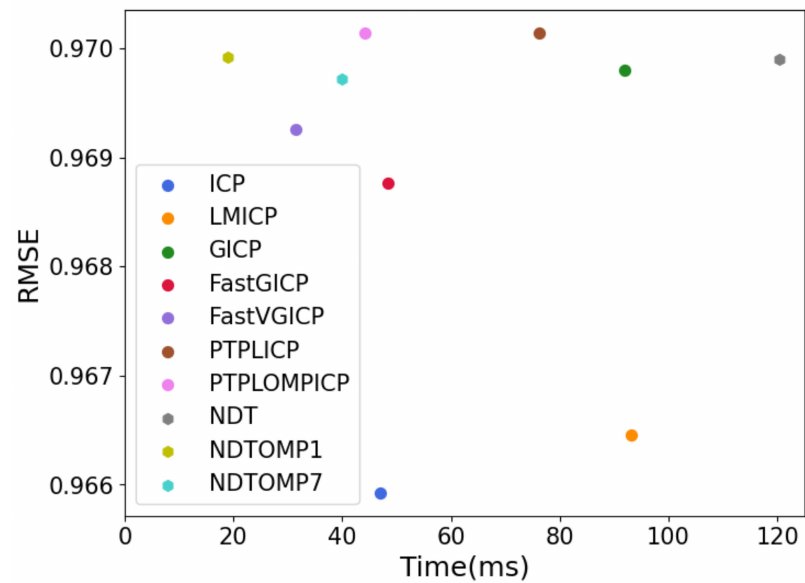
Figure 3. Comparison of registration algorithm